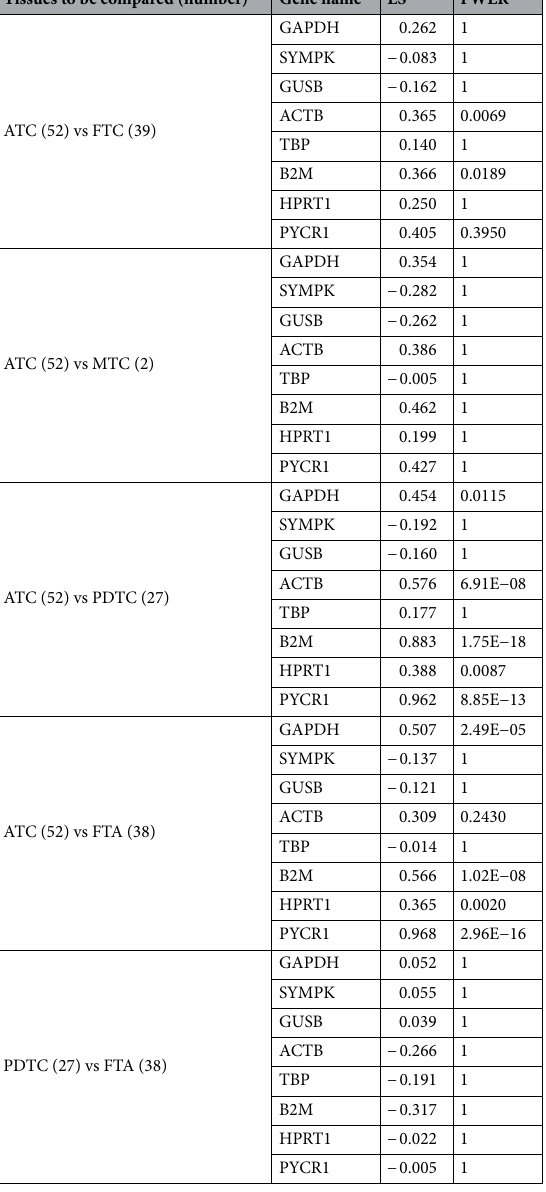
Table 2. Analyses of differential expression between normal tissues and thyroid cancer subtypes, as well as inter-subtype comparisions. The levels of expression of eight common reference genes are compared between normal tissues and each thyroid cancer subtype. Differential expression was calculated using a linear model: expression ~ tumor, where tumor was a binary variable (tumor vs. normal). The GAPDH gene is expressed differentially in PTC, FTC and ATC tissues than in normal tissues. Meaningful ES values for GAPDH , TBP and B2M are recorded in PTC tissues. GAPDH , PYCR1 and TBP have significant ES values in FTC tissues. The ES values of B2M and TBP are significant in PDTC tissues. In ATC tissues, GAPDH , ACTB , B2M , HPRT1 and PYCR1 all have a completely significant ES value. When compared to normal tissues, SYMPK gene retained its capability as a potential reference gene in all subtypes. The second section compares gene expression between undifferentiated (ATC subtype) and all other subtypes. A linear model was used to calculate differential expression: expression ~ tumor, where tumor was a binary variable (undifferentiated vs differentiated). GAPDH , with the except of FTC, shows significant differential expression between ATC and all other subtypes. Gene expression analyses are also carried out between poorly differentiated tissues (PDTC subtype) and all other differentiated subtypes (FTA, PTC, FTC, MTC). A linear model was used to calculate differential expression: expression ~ tumor, where tumor was a binary variable (poorly differentiated vs differentiated). There is no evidence of significant differential expression of any of the reference gene. For clarity, only PDTC versus FTA comparison is reported, and all other comparisons are omitted. ES effect size, FWER family-wise error